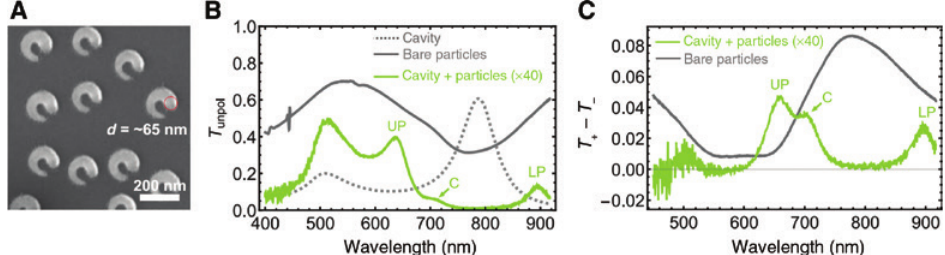
Figure 6: Experiments with chiral hybrid cavity-plasmon system. (A) SEM image of chiral Au nanocrescents on glass substrate with ~ 65 nm head diameter, assumed for FDTD simulations. (B) Unpolarized + transmission spectra of bare chiral nanocrescents on glass substrate, bare Fabry-Pérot cavity, and that of the coupled cavity- )( /2 T T + − plasmon system. UP and LP label the position of upper and lower cavity-plasmon polaritons, whereas C labels the middle “uncoupled” peak due to in-plane anisotropy of the particles. (C) CD spectra of the same two systems, showing emerging mode splitting in CD of the coupled plasmon-cavity